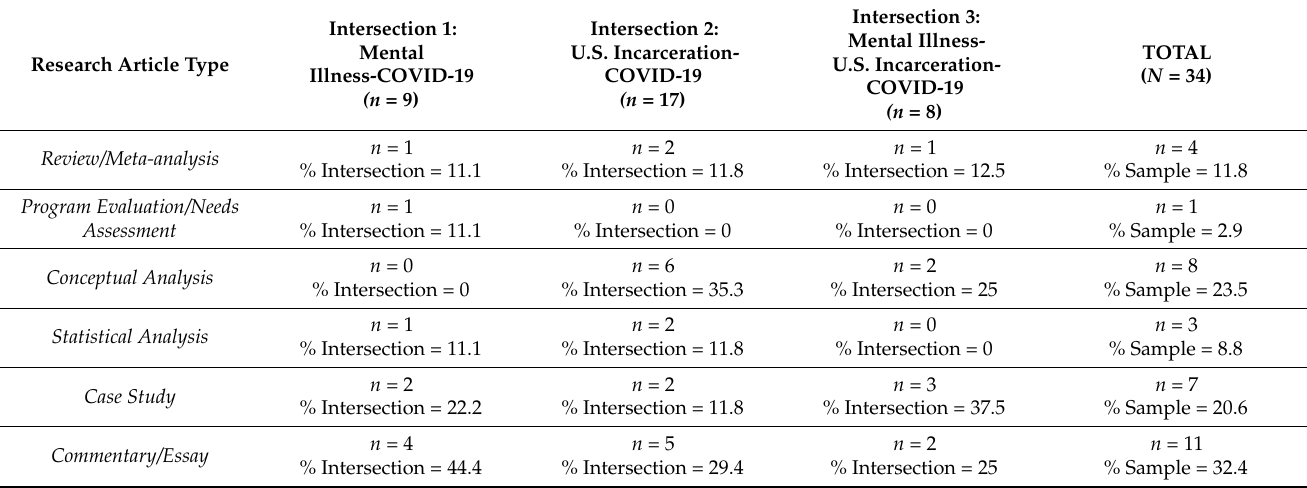
Table 3. Distribution of Peer Reviewed Literature across Intersection by Research Article Type ( N =